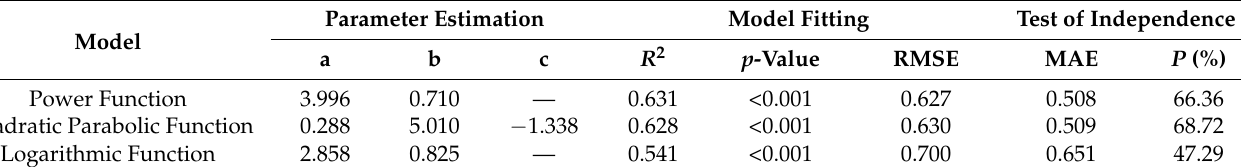
Table 3. The parameter estimation and model evaluation for three CPMs.